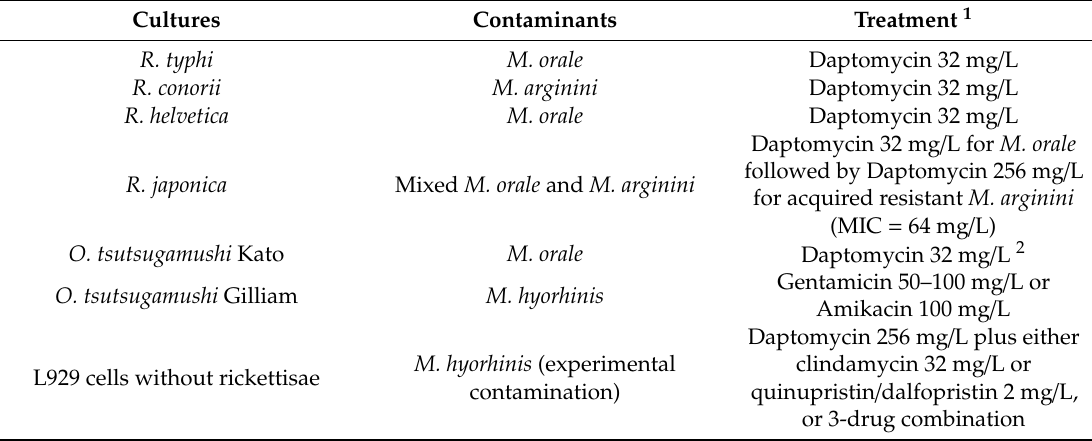
Table 2. Successful Mycoplasma Decontamination Protocols in this